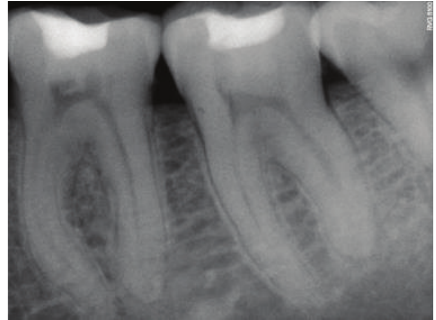
Figure 20: 6-month followup RVG: 36, 37.